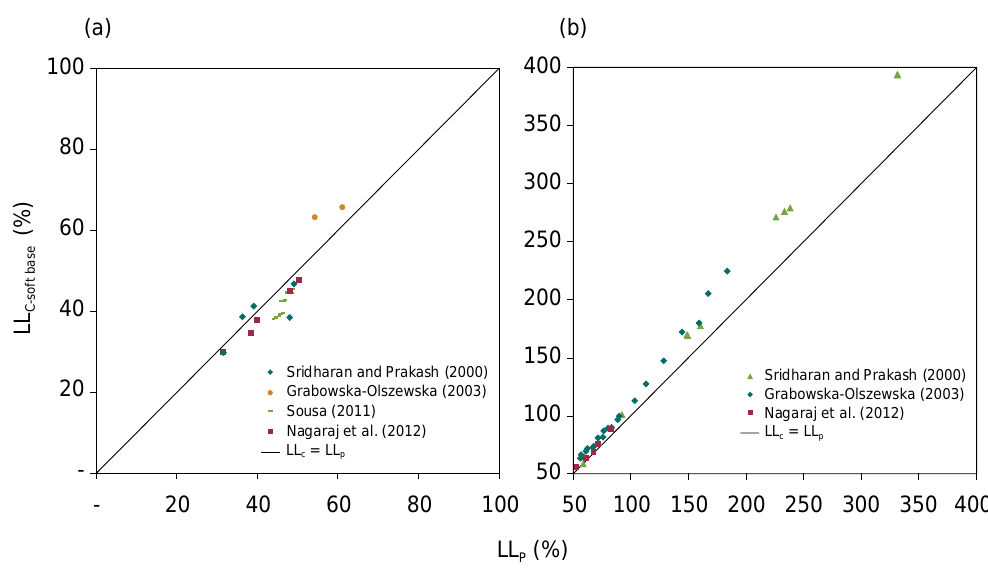
Figure 4. Experimental results (LL p – LL c-soft base ) of the soils investigated in group B-02 in this research: subgroup B-02i with n = 28 formed essentially by kaolinites and illites (a); and subgroup B-02ii with n = 39 consisting essentially of smectites (b).